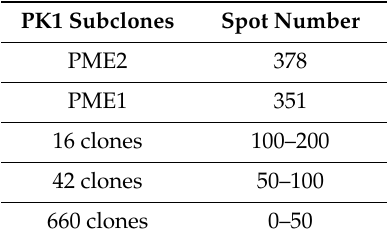
Table 1. Rare PK1 subclones are weakly permissive to Me7 prions.